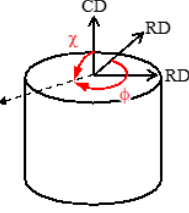
Figure 1. Schematic illustration showing the definition of χ and φ in the ND experiments, where Q is the neutron scattering vector.